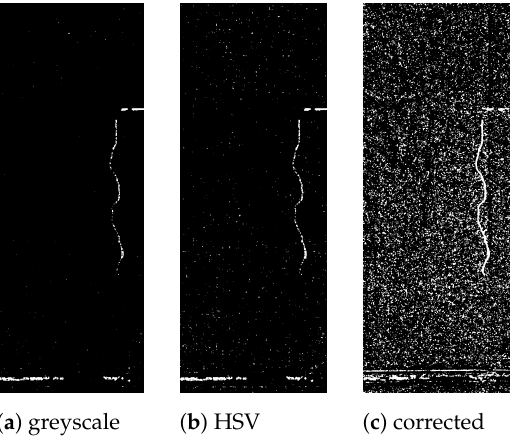
Figure 10. Change maps from SSIM. Greyscale ( a ), HSV ( b ) and corrected ( c